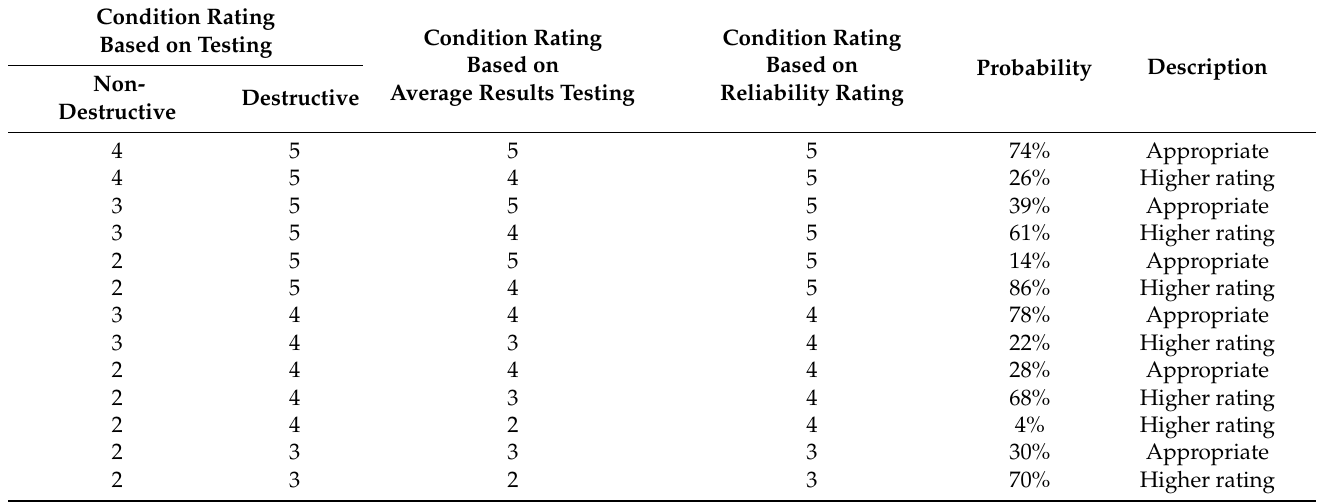
Table 4. The increment in the condition rating values resulting from the assessment.